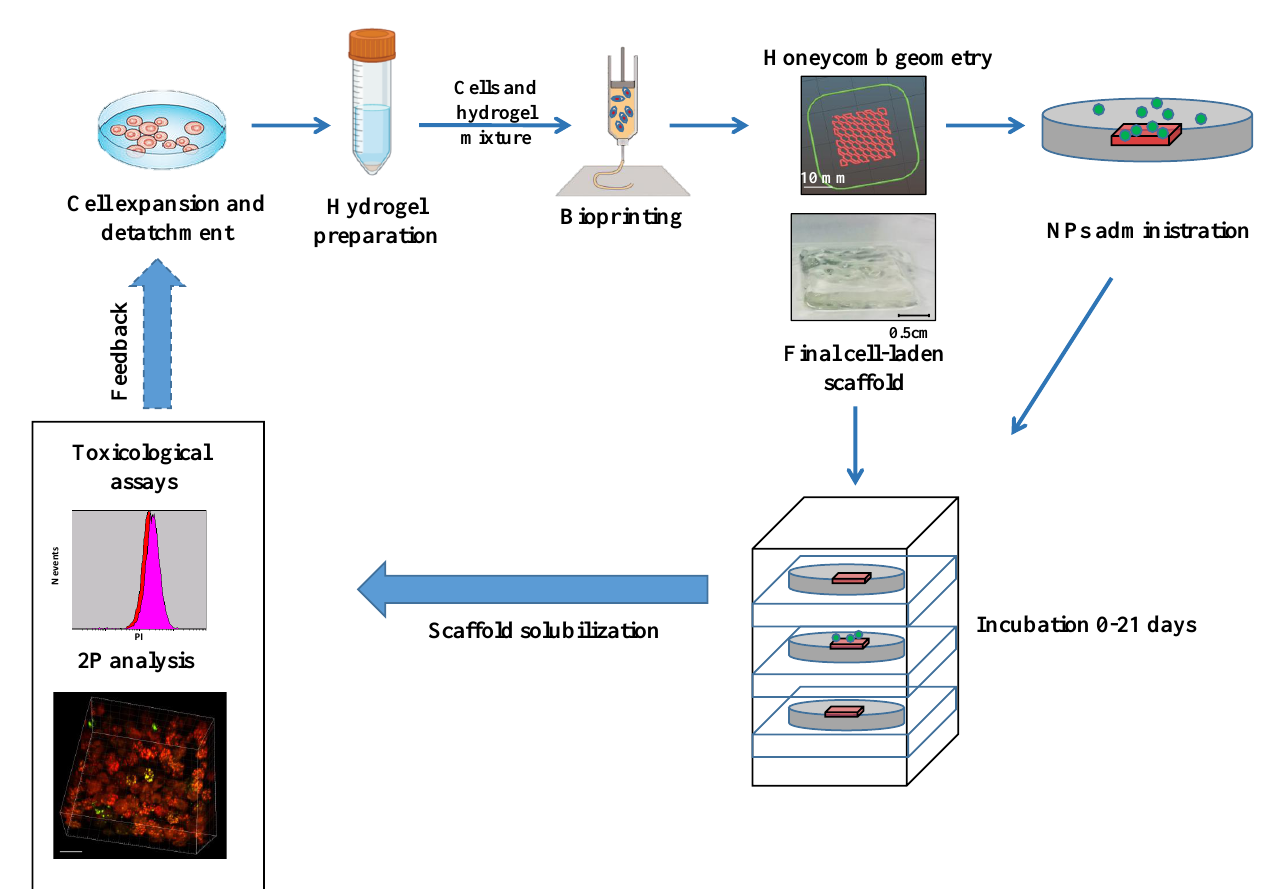
Figure 2. Study overview and experimental protocol. Experimental protocol for cell-laden multi- layer generation, imaging and toxicological assay. Feedback was adopted to better define the 3D printing process parameters. NPs: carboxyl fluorescent nanosphere or polydispersity colloidal silver nanoparticles, 2P: two-photon microscopy. Modified from